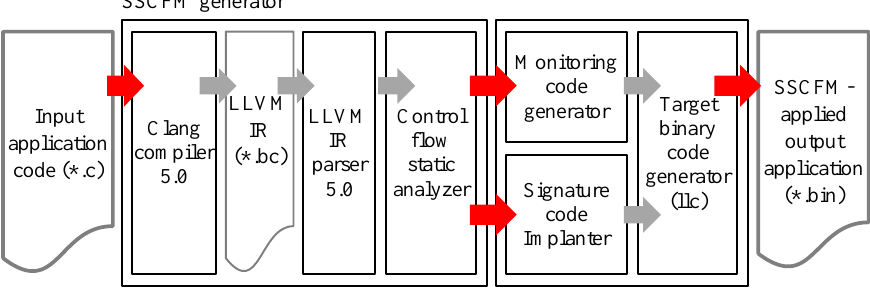
Figure 8. Overall structure of the code-generation framework for the SSCFM